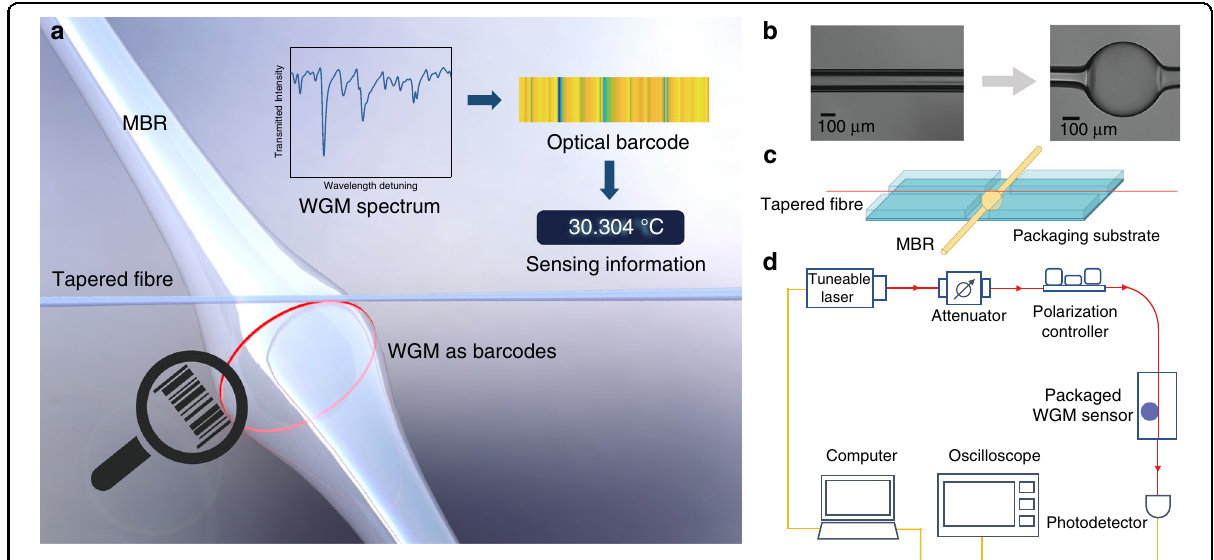
Fig. 1 Optical WGM barcode sensing system. a Schematic of WGM sensing using the optical barcode technique. The light is coupled into and out of the MBR via a tapered fi bre. We can directly obtain the sensing information from the optical barcode generated from the transmission spectrum. b Optical micrograph of the capillary (left) and fabricated MBR (right). The MBR is in the middle supported by capillaries on both sides. c Schematic of the packaged substrate containing the MBR and the tapered fi bre. d Schematic of the setup. The light from a tuneable laser is used to probe the spectrum of the packaged WGM sensor. The light intensity is controlled by the attenuator and the polarization is controlled by the polarization controller. The transmission spectrum is received by a photodetector, which is connected to an oscilloscope and a computer with a data acquisition card for control of laser scanning and signal